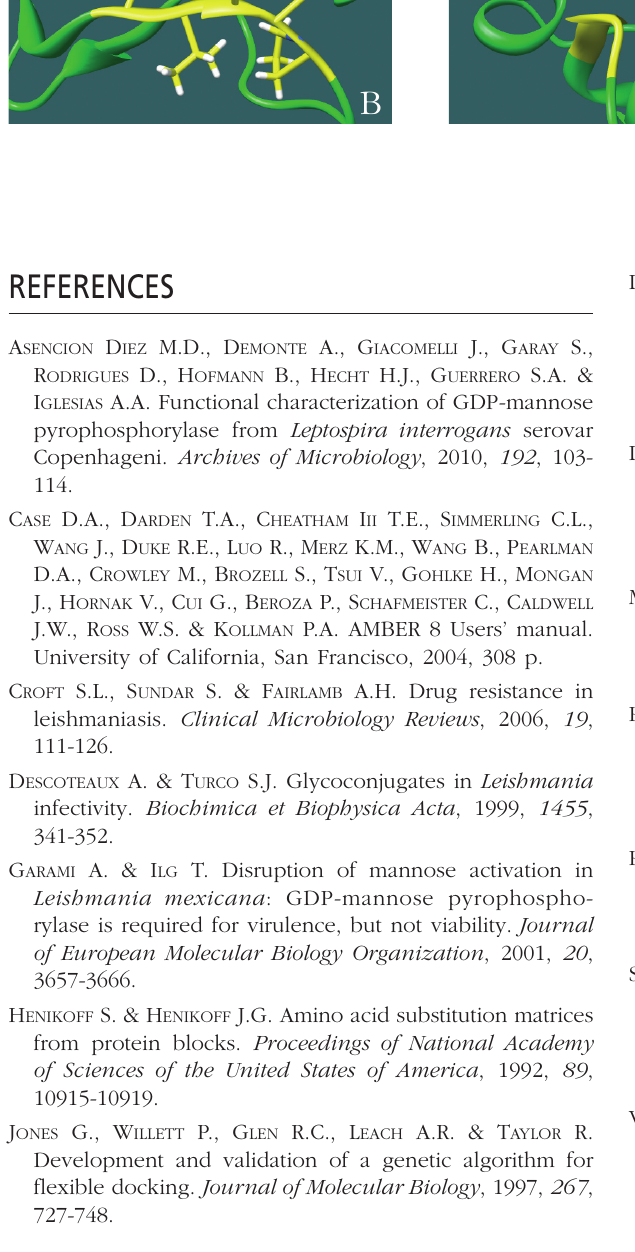
B. Interactions mediated between GDP-mannose (purple) and the F(V)EKP conserved motif of the L. infantum GDP-MP (green). The amino acids of the conserved motif (yellow) are represented in sitck. The red lines represent H-bonds. The specific motif is colored in white. C. Interactions mediated between GDP-mannose (purple) and the specific motif of the L. infantum GDP-MP (green). The amino acids of the specific motif (white) are represented in stick. The red lines represent H-bonds. The F(V)EKP conserved motif is colored in